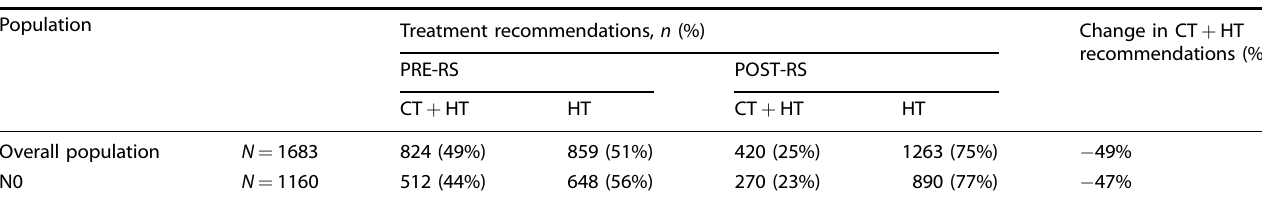
TABLE 5. Expected recommendations assuming decision-making according to TAILORx results.